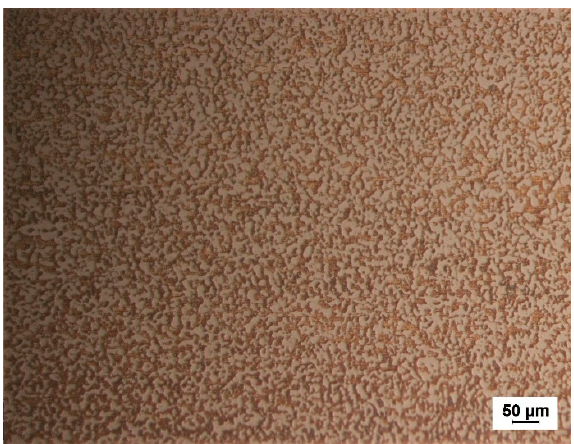
Figure 1. Optical microstructure of the hypereutectic Al-50Si alloys.